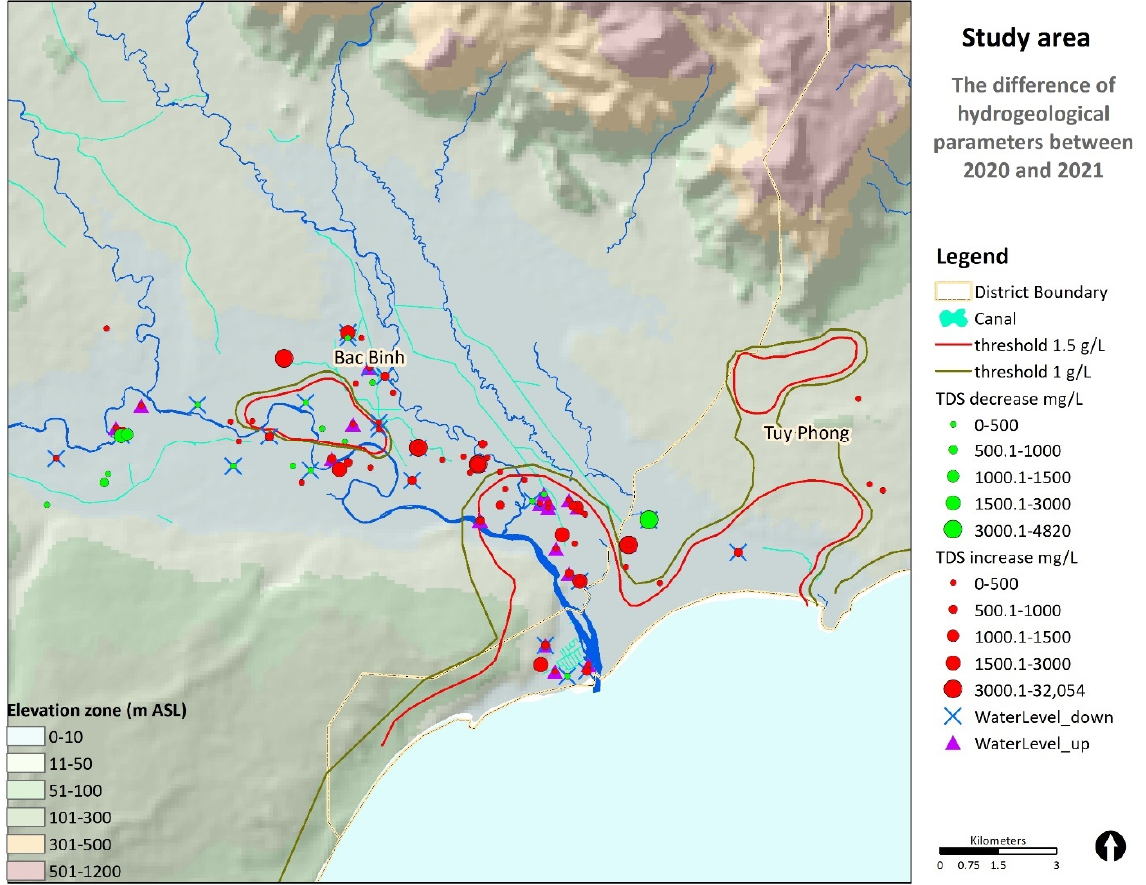
Figure 11. The difference of the hydrogeological parameters between 2020 and 2021.